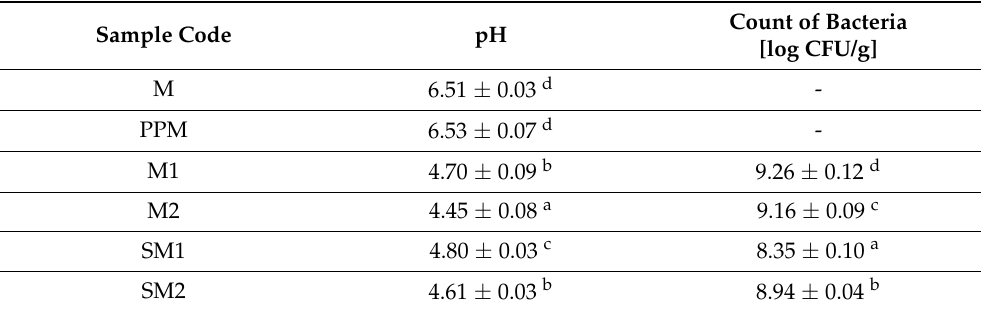
Table 3. Changes in the count of LAB bacteria and pH values during pumpkin pulps fermentation (cultivar “ Miranda ” of the Cucurbita moschata